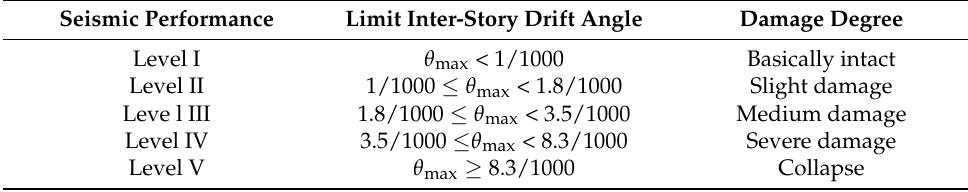
Table 1. Seismic performance level of shear wall structures.